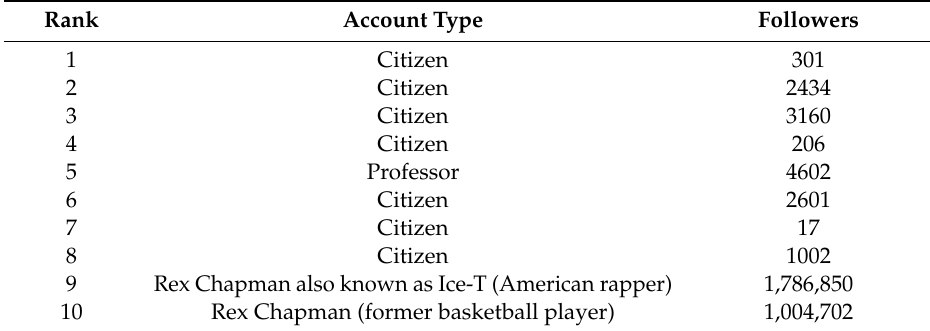
Table 2. Top 10 users ranked by betweenness centrality.